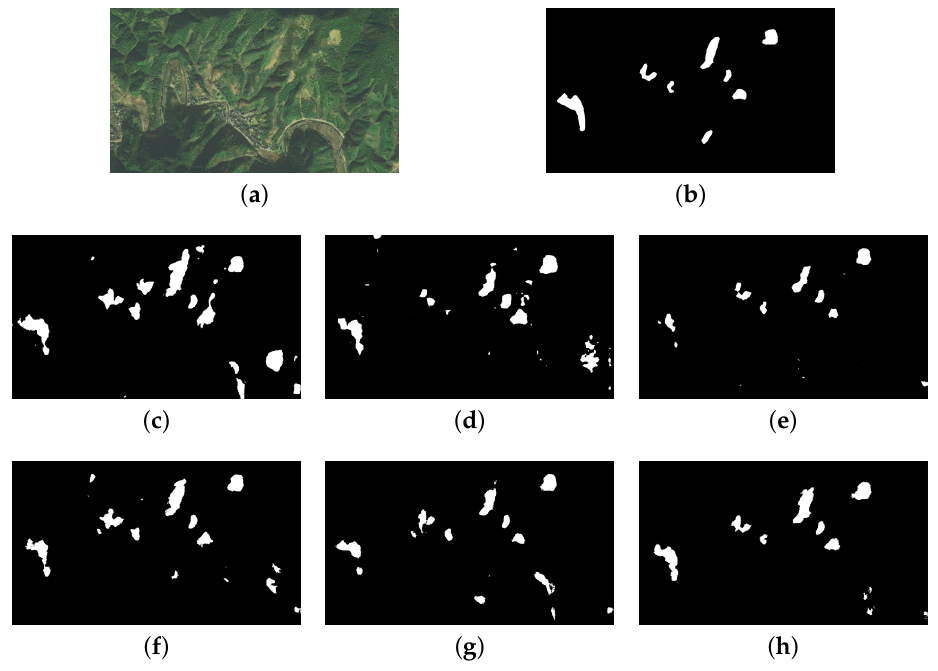
Figure 9. Extraction results: ( a ) image; ( b ) label; ( c ) extraction results of the U-Net model; ( d ) extrac- tion results of the Deeplab v3+ model; ( e ) extraction results of Liu et al.’s [21] model; ( f ) extraction results of the DDCM-Net model; ( g ) extraction results of the MACU-Net model and ( h ) extraction results of the L-Unet